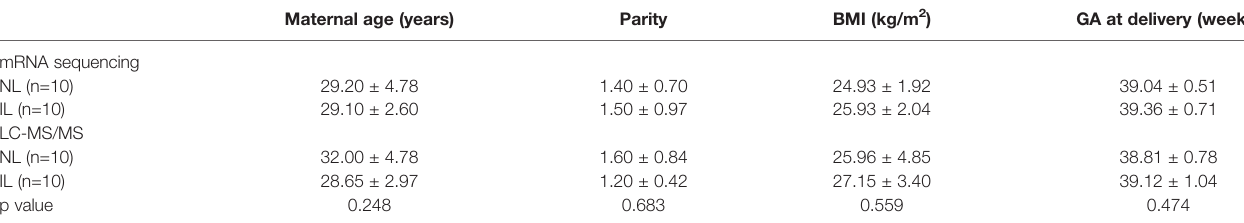
TABLE 1 | Characteristics of the women who provided myometrium